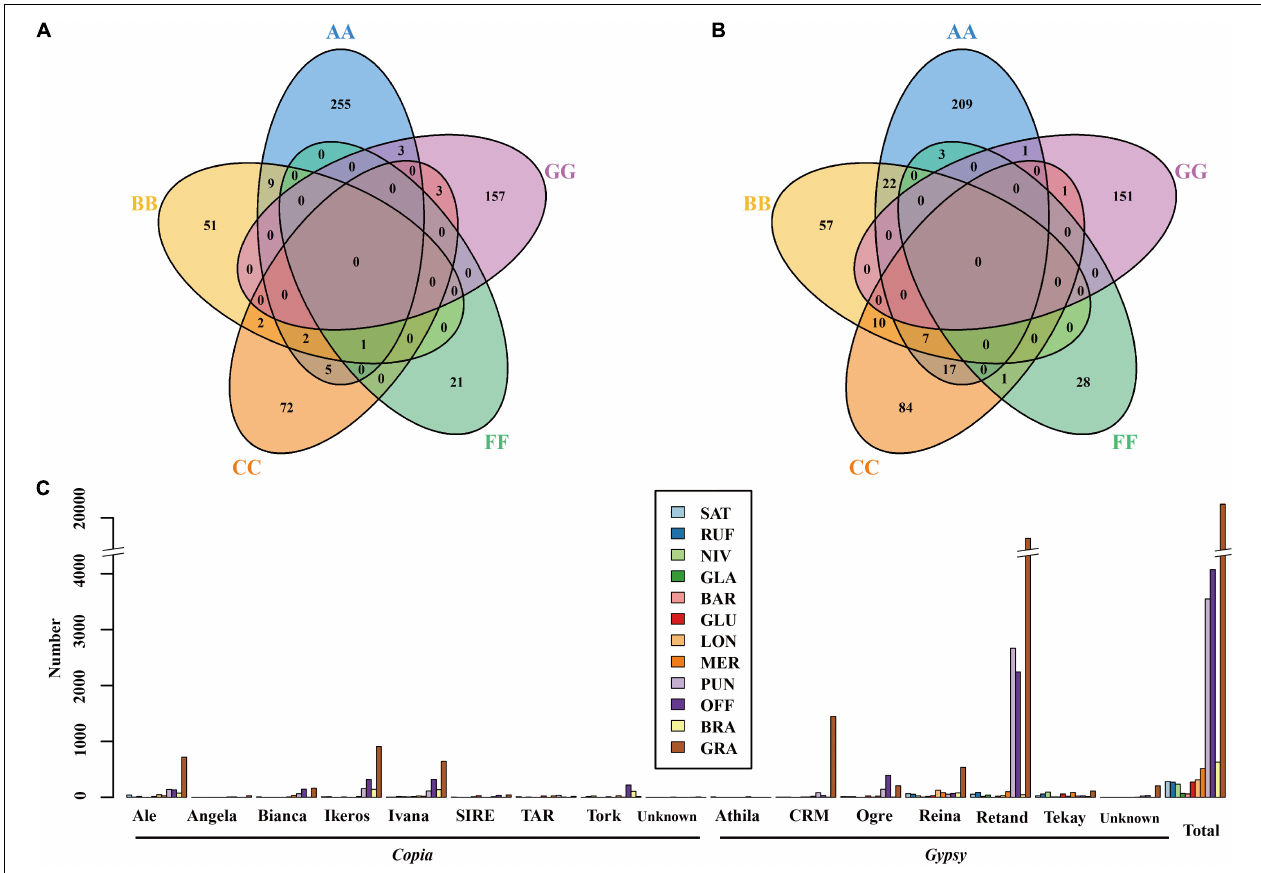
FIGURE 4 | Venn diagrams of LTR-RT families belonging to the Gypsy (A) and Copia (B) superfamilies among the five (AA-, BB- CC-, FF-, GG-) rice genome types, and lengths of species-specific intact LTR-RTs of the 12 Oryza genomes (C)